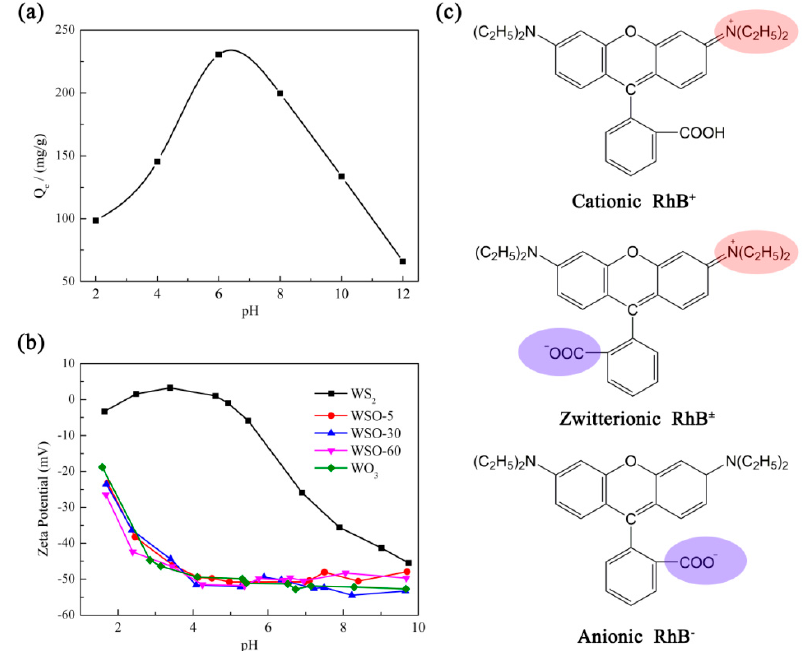
Figure 11. ( a ) The effect of the pH on the adsorption of RhB on WSO ‐ 5. (Adsorbent = 20 mg, RhB = 40 mL of 200 mg/L, T = 30 °C.) ( b ) The Zeta potential of WS 2 , WS 2 /WO 3 hybrids, and WO 3 at various pH values. ( c ) The molecular structures of RhB in its zwitterionic, cationic, and anionic form, respectively.